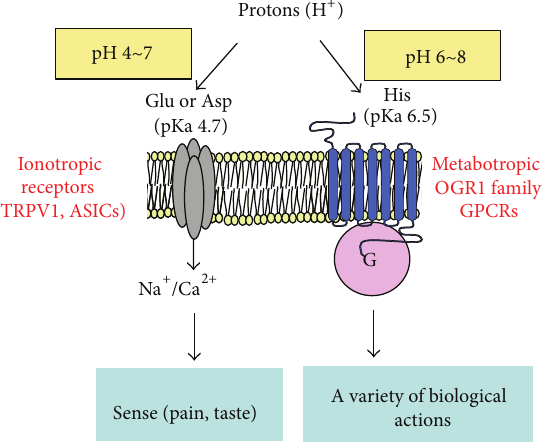
Figure 1: Ionotropic and metabotropic proton-sensing receptors. Extracellular acidification evokes a variety of airway responses. Ionotropic TRPV1 channel and ASICs mainly mediate severe acidic pH-induced cough, pain, and bronchoconstriction through sensory neurons, while OGR1-family GPCRs sense mild alkaline and mild acidic pH and exert a wide range of cellular actions in many types of structural and inflammatory